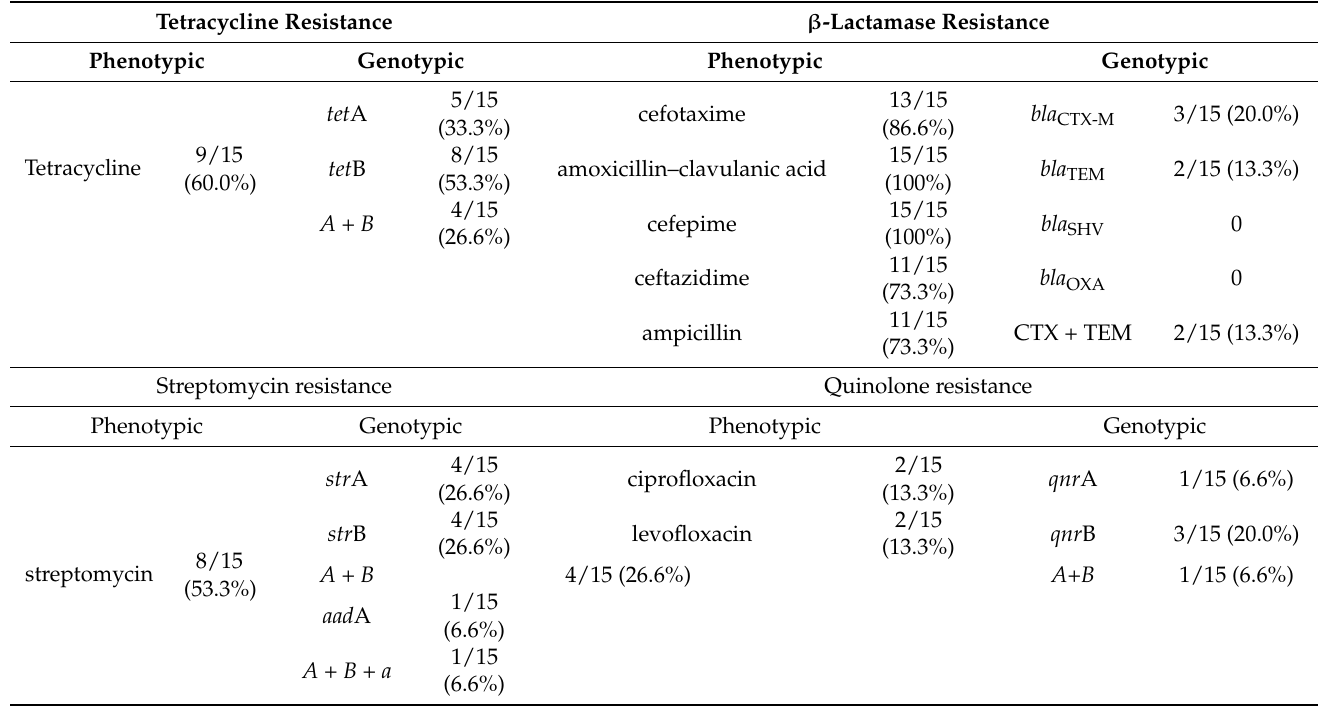
Table 3. Distribution of resistance genes in Escherichia coli isolates from meat. Tetracycline